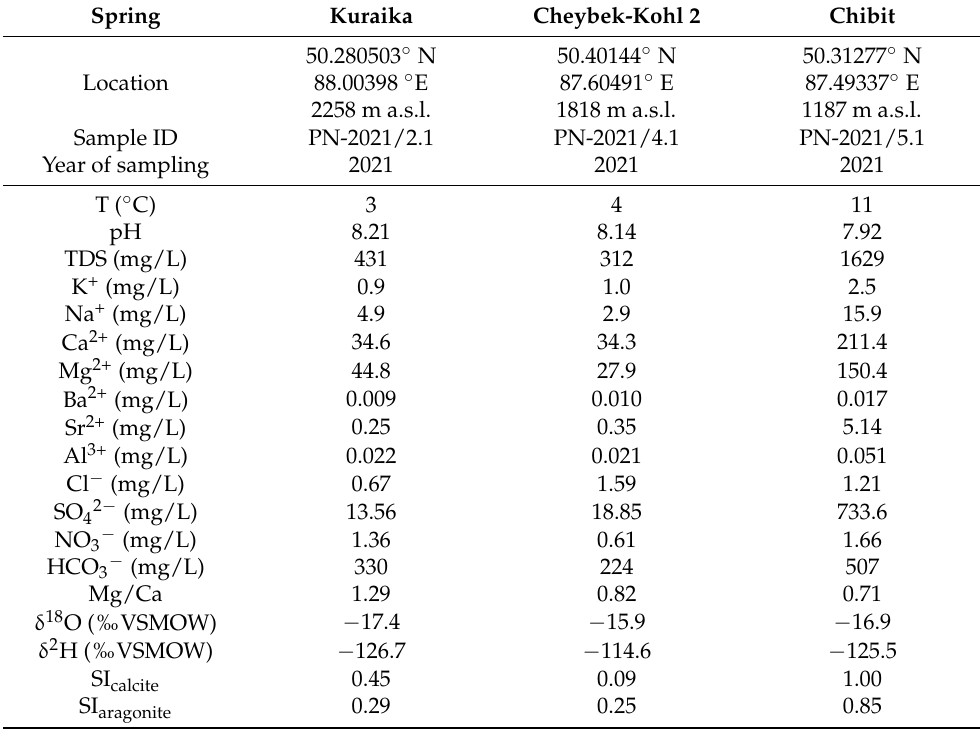
Table 1. Chemistry and stable isotope composition of waters of the travertine springs of the south- eastern Gorny Altai.